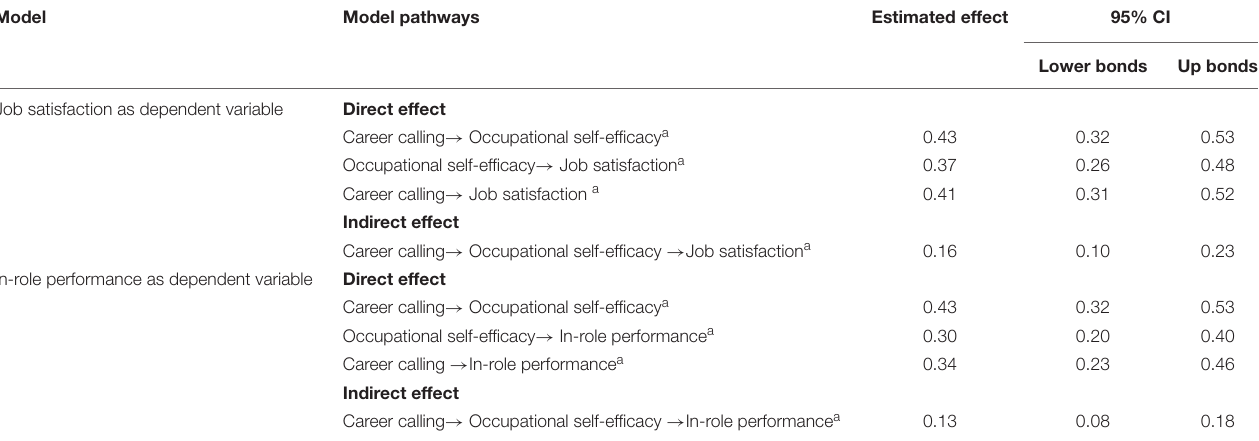
TABLE 4 | Standardized effect and 95% CIs for the final model.